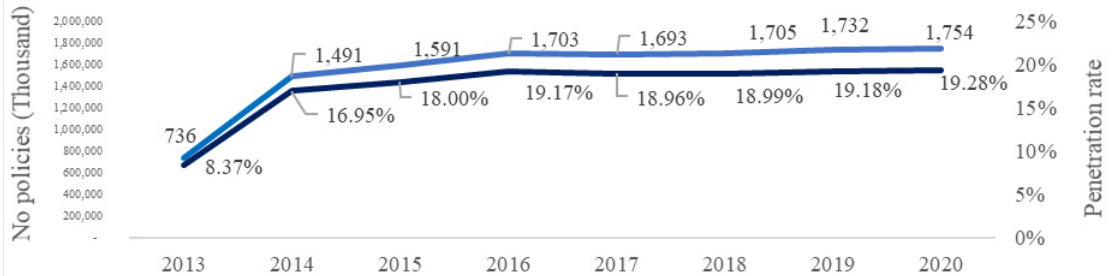
Figure 1. Mandatory (PAD) portfolio evolution for 2013–2020. Source: data obtained according to the calculations of the author based on data from PAID and the National Institute of Statistics of Romania.